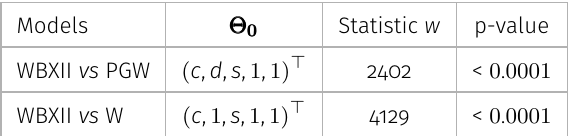
Table XI. Likelihood ratio statistics for the fits to the baseball players